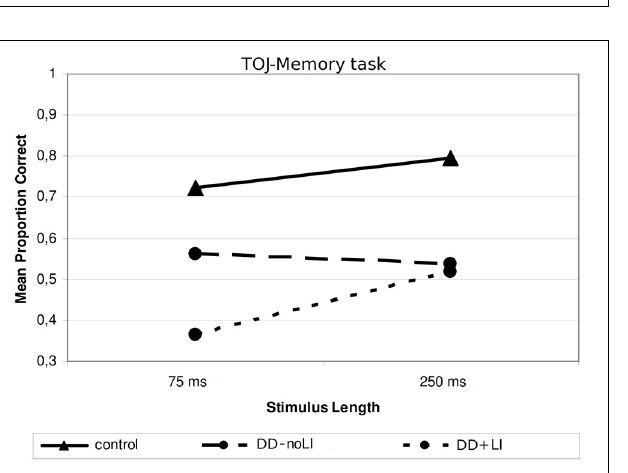
FIGURE 5 | Mean proportion of correct answers in the TOJ—Memory task for the subgroups divided according to Language.